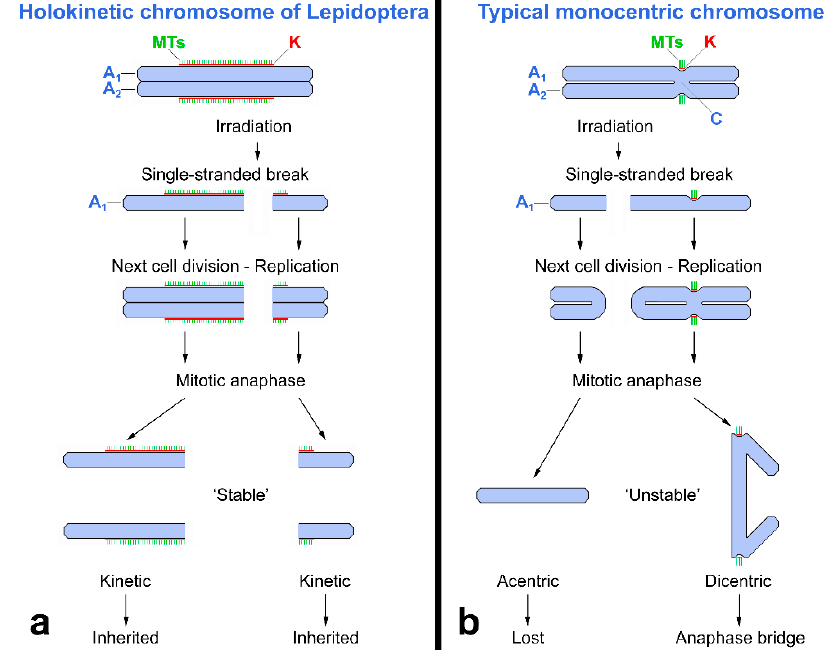
Figure 6. Comparison of structure of holokinetic and monocentric mitotic chromosomes and consequences of chromosome breakage. ( a ) Holokinetic chromosome of Lepidoptera with two sister chromatids (A 1 and A 2 ), each with a large kinetochore plate (K) covering about 50% of the chromosome surface; spindle microtubules (MTs) are attached to the kinetochore. ( b ) Typical monocentric chromosome, where sister chromatids are linked in a primary constriction, the centromere (C); the kinetochore (K) is localized on the surface of the centromere (modified according to [11]).